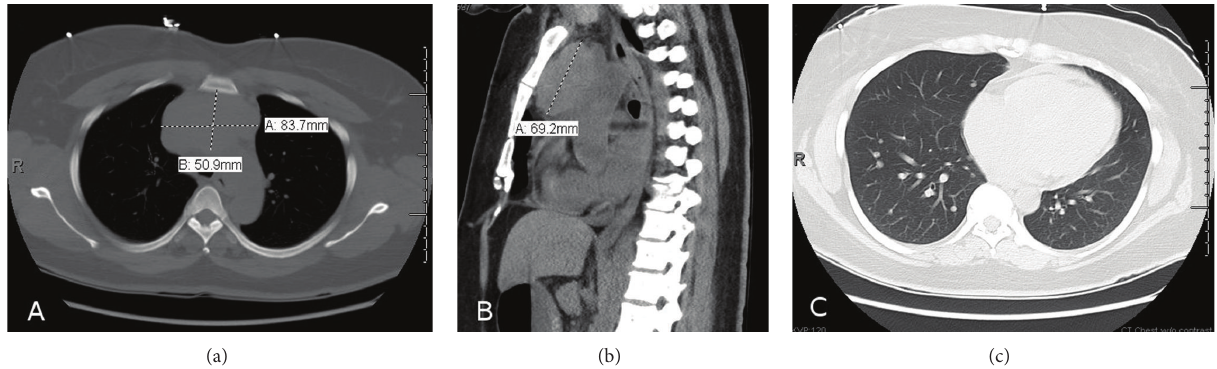
Figure 1: CT scan of the lung showing anterior mediastinal mass measuring 8.4 × 5.1 × 7 cm in anteroposterior (a) and lateral view (b) along with pulmonary nodules (c).